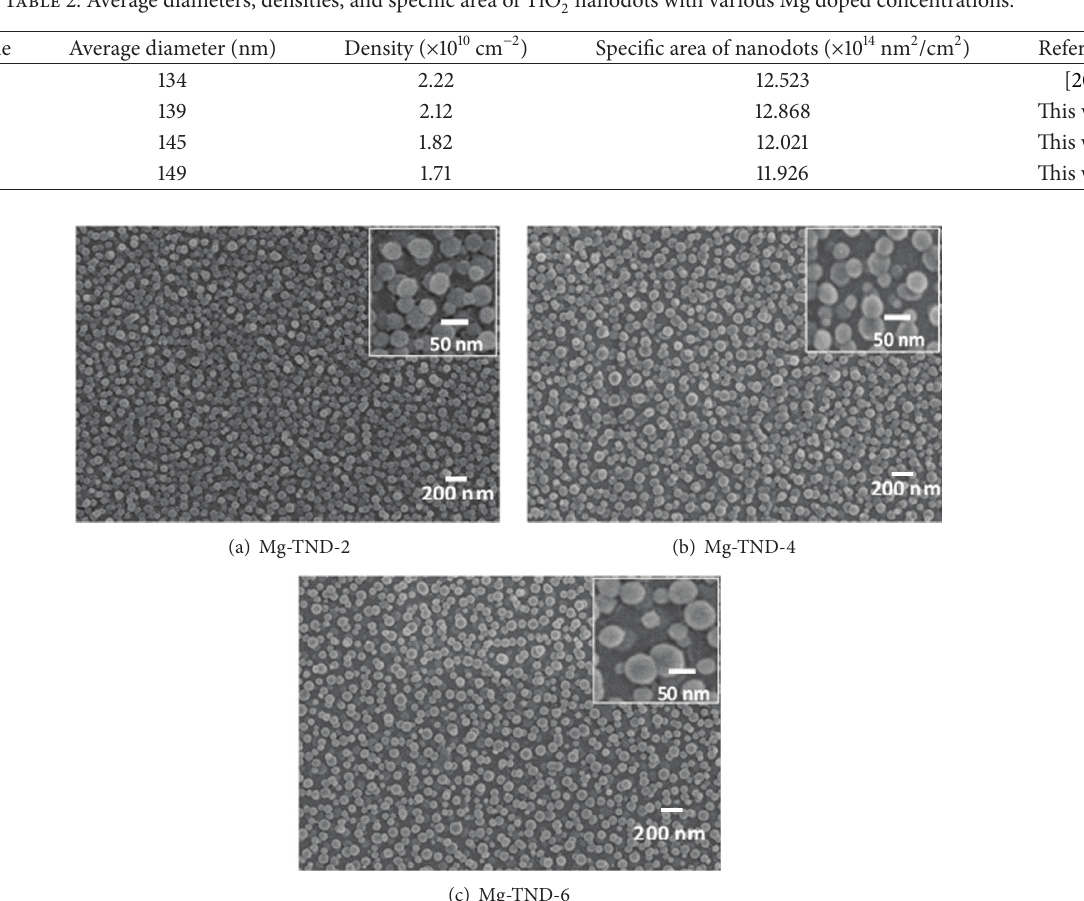
Table 2: Average diameters, densities, and specific area of TiO